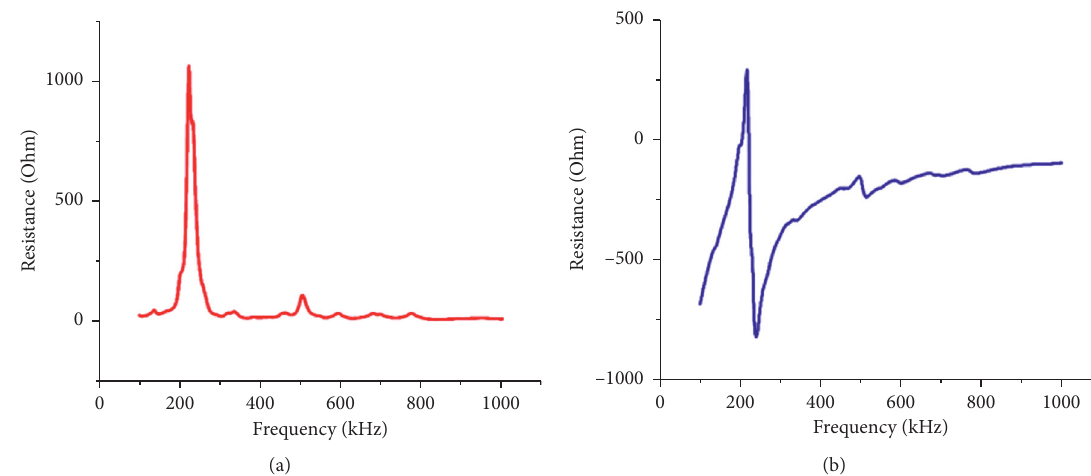
Figure 6: Resistance and reactance signatures at frequency range from 100kHz to 1MHz. (a) The relationship between resistance and frequency. (b) The relationship between reactance and